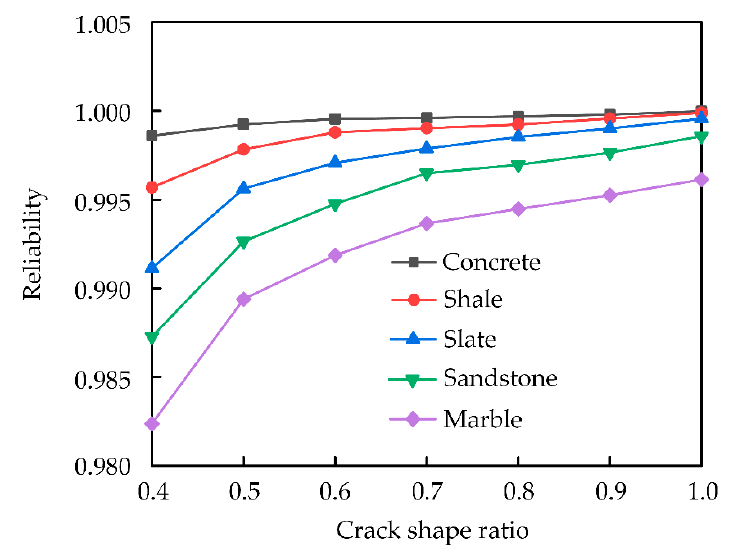
Figure 11. Relationship between the reliability of the cutterhead and the crack shape ratio.